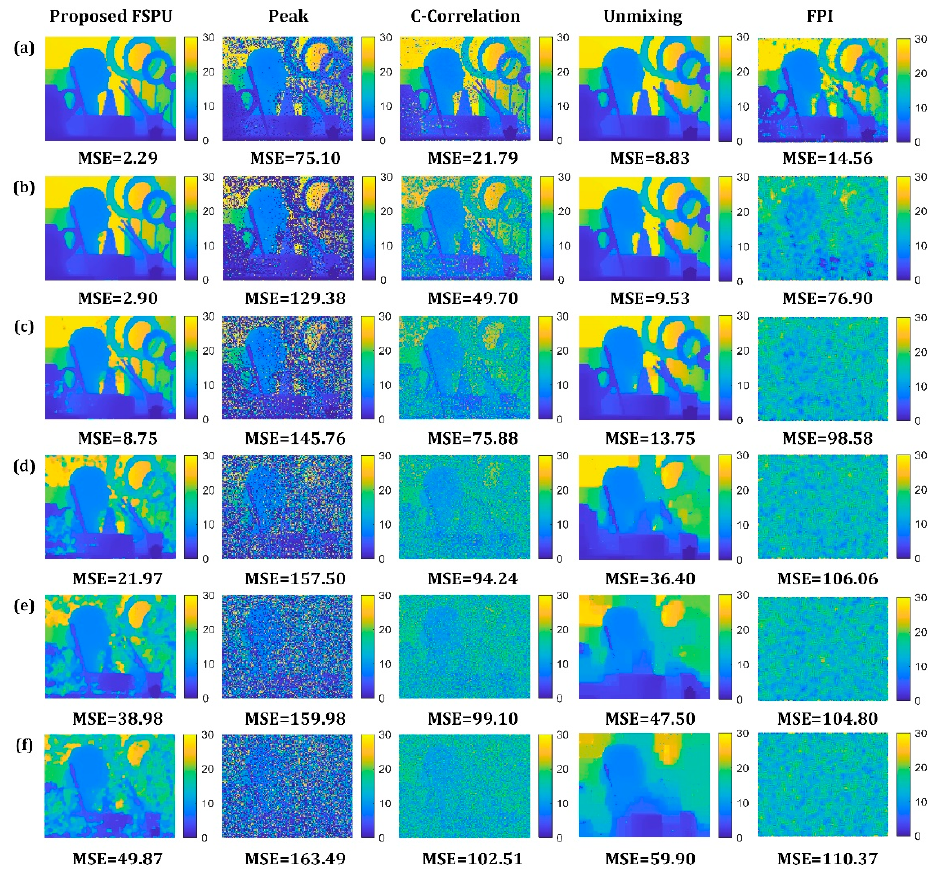
Figure 5. Performance comparison between methods on different noise levels. ( a ) 0.01 MHz noise (SNR = 4.5 dB), 3183 ppp for the first four methods, 335 ppp for FPI; ( b ) 0.1 MHz noise (SNR = − 5.5 dB), 3313 ppp, 81 ppp; ( c ) 0.25 MHz noise (SNR = − 9.5 dB), 2514 ppp, 37 ppp; ( d ) 0.5 MHz noise (SNR = − 12.5 dB), 1755 ppp, 20 ppp; ( e ) 0.75 MHz noise (SNR = − 14.3 dB), 1358 ppp, 14 ppp; ( f ) 1 MHz noise (SNR = − 15.5 dB), 1088 ppp 10 ppp.